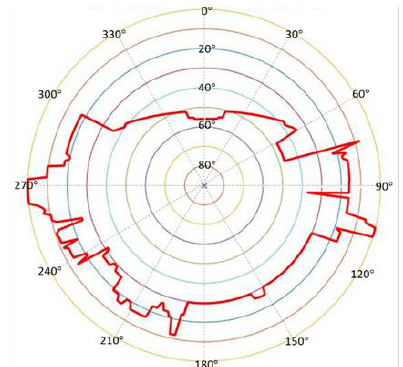
Figure 16. Skyplot of point